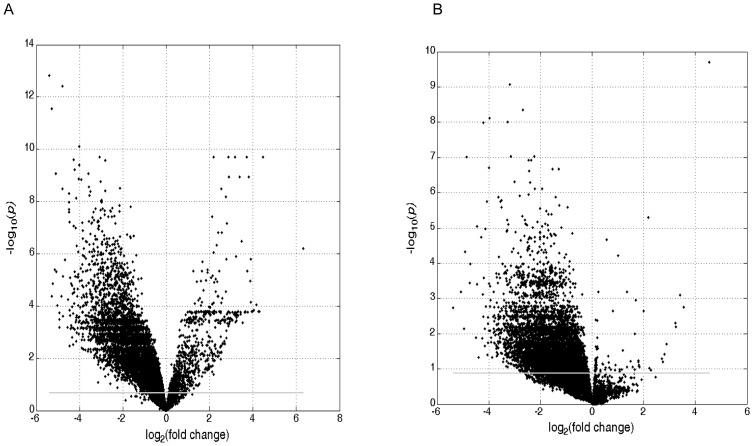
Volcano plot for difference in gene expression between heart tissues from DOX treated rats versus heart tissues from control rats (A) and PBMC tissues from DOX treated rats versus PBMC tissues from control rats (B).The gray horizontal line demarks FDR = 0.05 so values with FDR<0.05 are above the line. FDR>2 have log2 fold change >1 and fold change <1/2 have log2 fold change <−1.